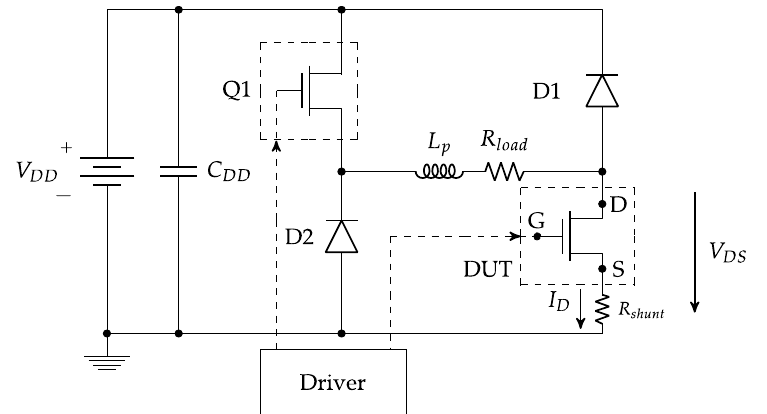
Figure 3. The circuit diagram that was used to measure the dynamic R ON . Transistor Q1 was used to control the stress/trapping time. A resistive load (R load ) was used to set the current level when the DUT was in the on state. Due to the inherent parasitic inductance (L p ) of the power R load , two SiC diodes (D1 and D2) offered a freewheeling path for the current when either Q1 or the DUT was switched from on to off. The test sequence of the double pulse measurement is shown in Figure 4. This sequence consisted of stressing the device with a drain voltage for 60 s while it was in the off state and then switching